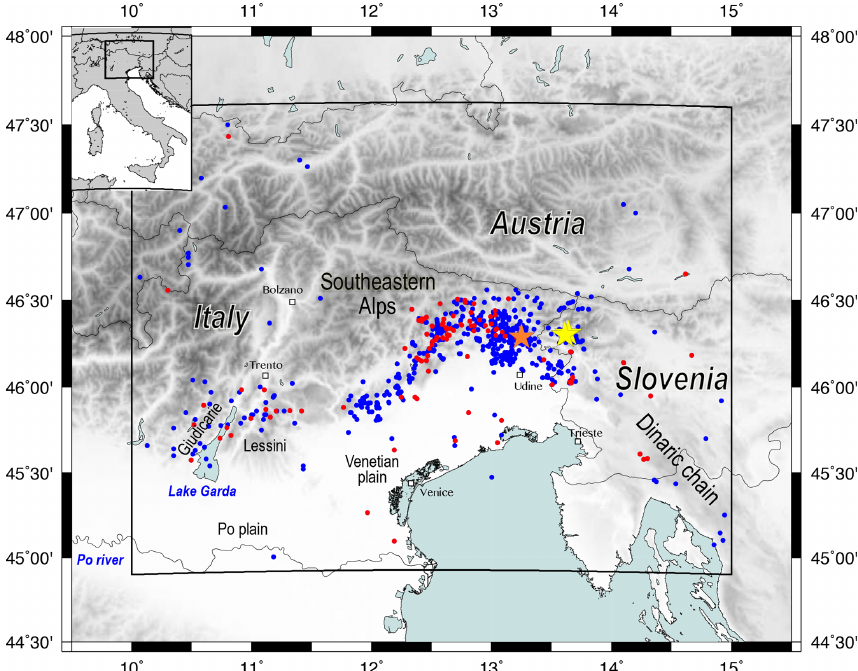
Figure 1. Map of the epicentres of the focal mechanisms reported in the catalogue (Saraò et al., 2021) presented in this paper. The epicentres of the focal mechanisms retrieved from the literature are indicated by the blue dots, and the newly computed FPSs are indicated by the red dots. The 1976 Friuli earthquake (orange star) and the 1998 and 2004 Bovec earthquakes (yellow stars) are also shown. The map was generated by GMT software (Wessel et al.,